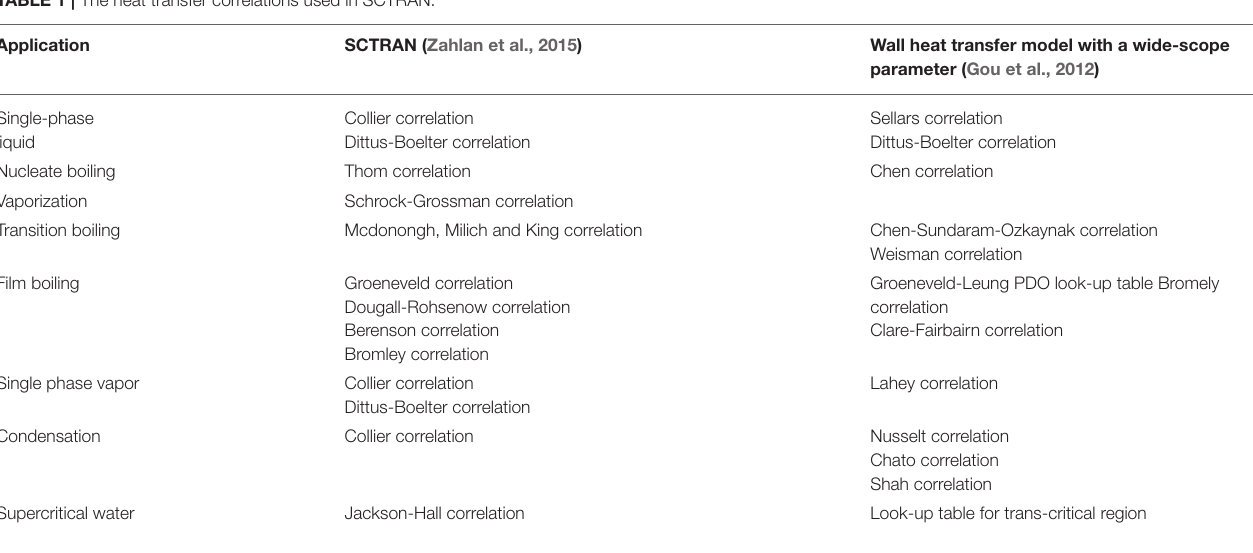
TABLE 1 | The heat transfer correlations used in